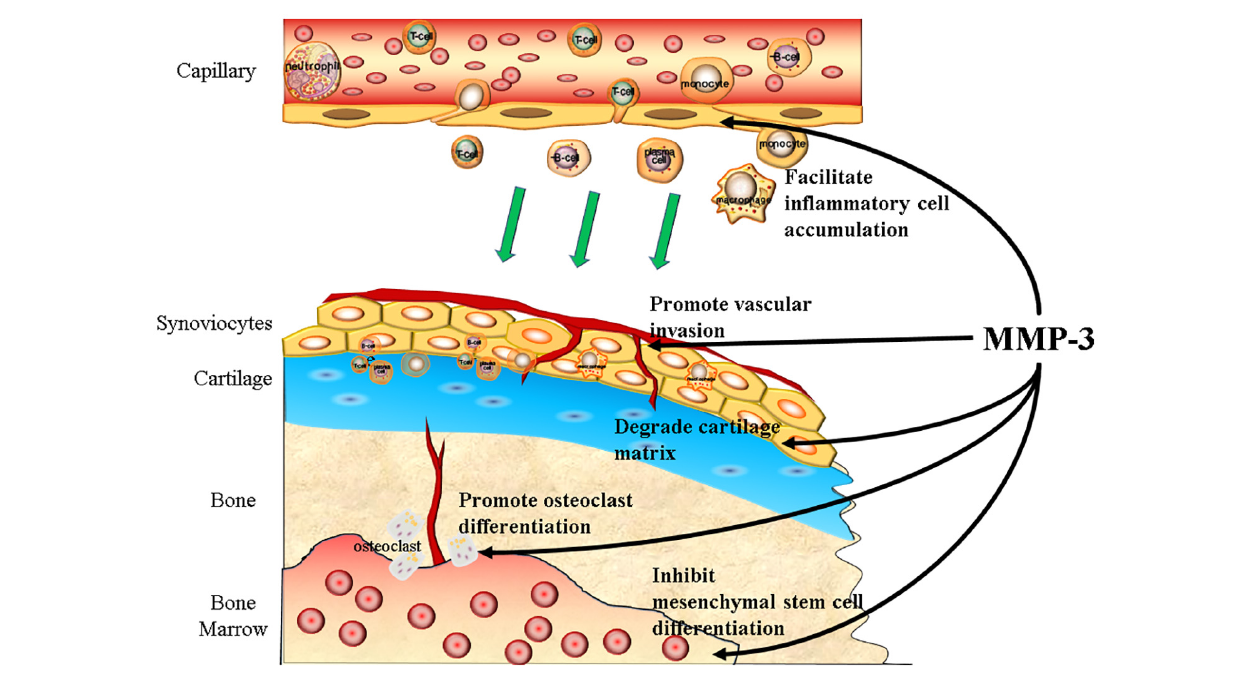
FIGURE 2 | MMP-3 participates in the progression of OA. MMP-3 can promote the progression of OA both in preclinical and clinical stage. To be precisely, MMP-3 can facilitate the inflammatory cells accumulation, promote vascular invasion, degrade cartilage matrix, promote osteoclast differentiation, and inhibit mesenchymal stem cells